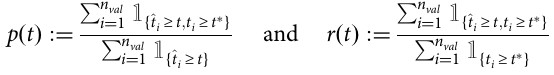
and their associated genes' g ; indel